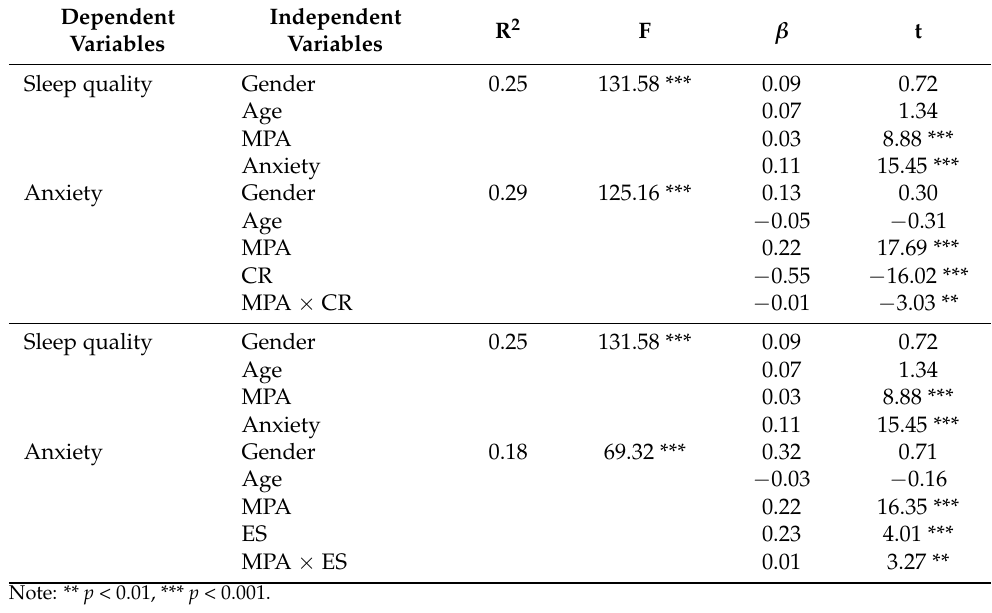
Table 4. Regression analysis of the moderating effect of CR and ES on the mediating effect of anxiety.